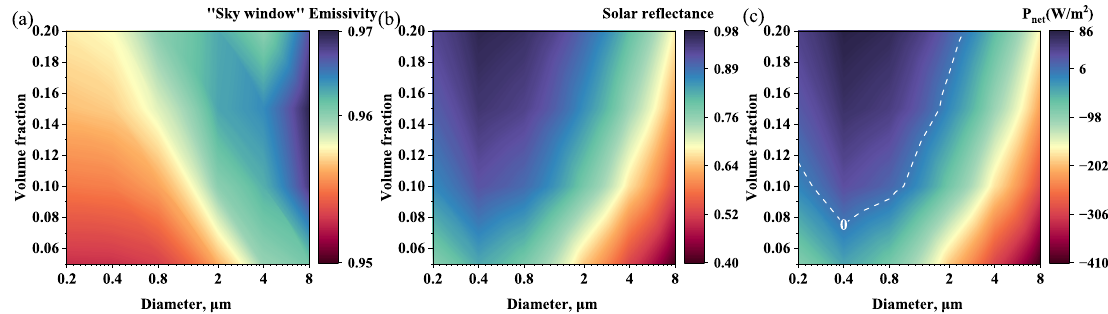
Figure 5. Effect of the microstructure of PC porous films on ( a ) “sky window” emissivity ¯ ε LWIR , ( b ) solar reflectance ¯ R solar , and ( c ) net cooling power P net .